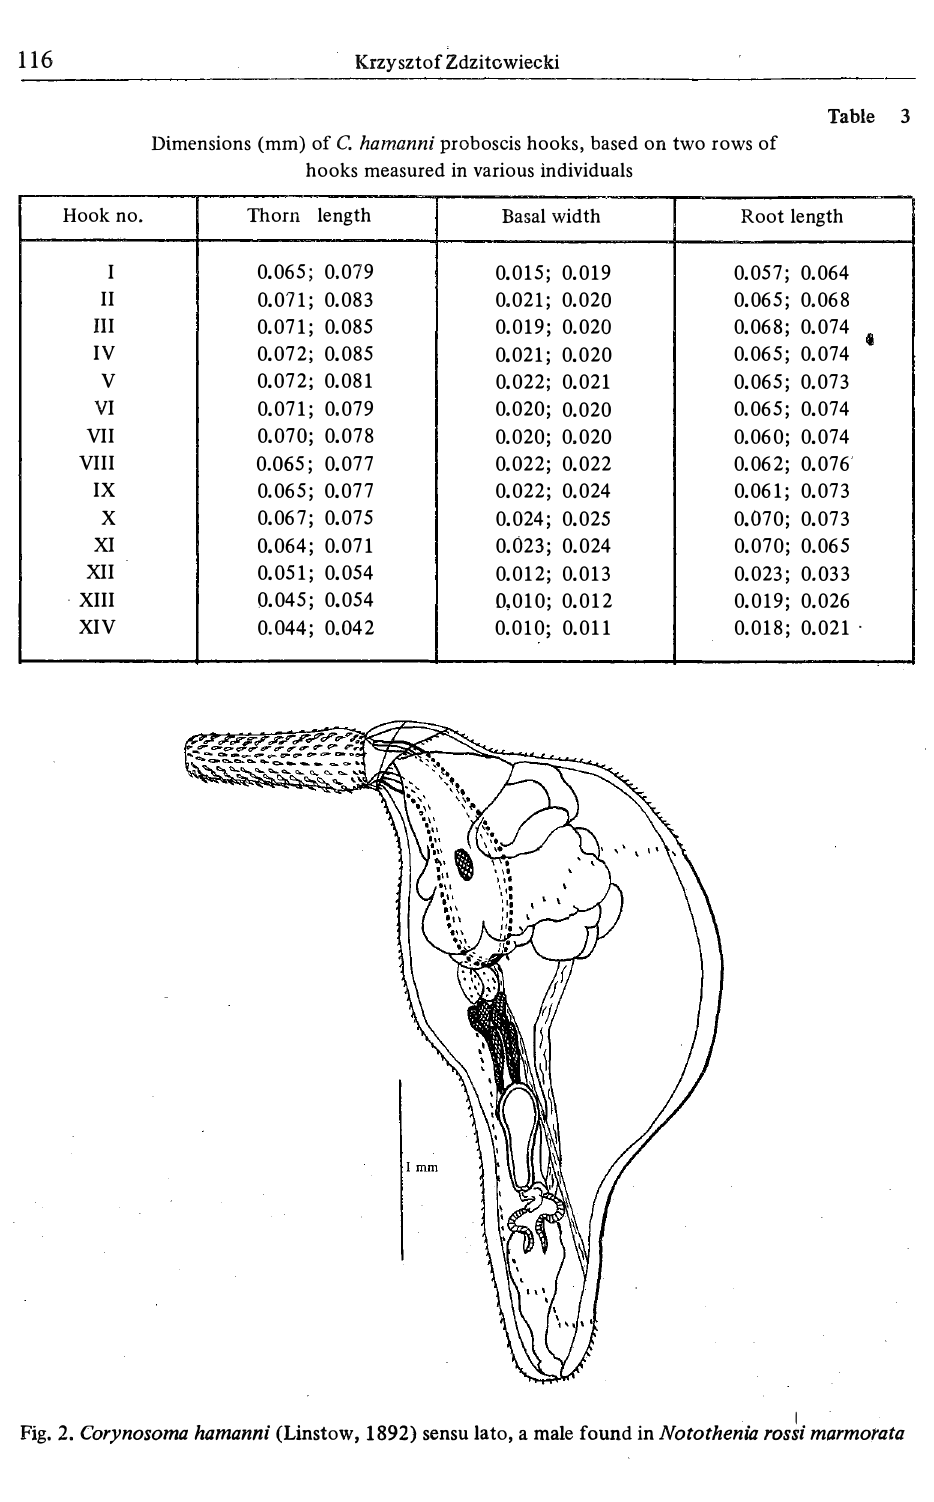
Fig. 2. Corynosoma hamanni (Linstow, 1892) sensu Jato, a male found in Notothenia ros:i